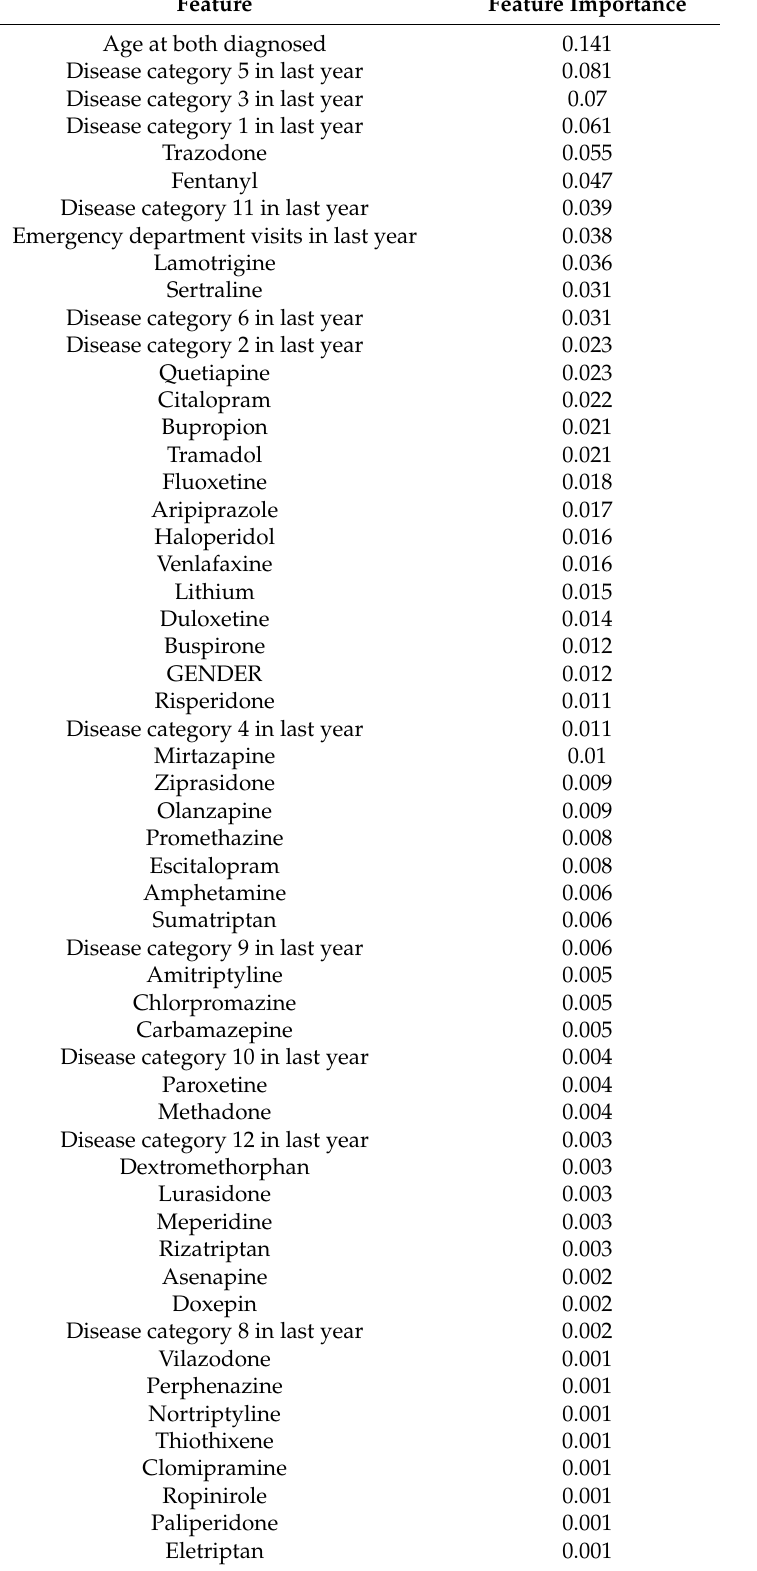
Table 3. Feature importance in random forest